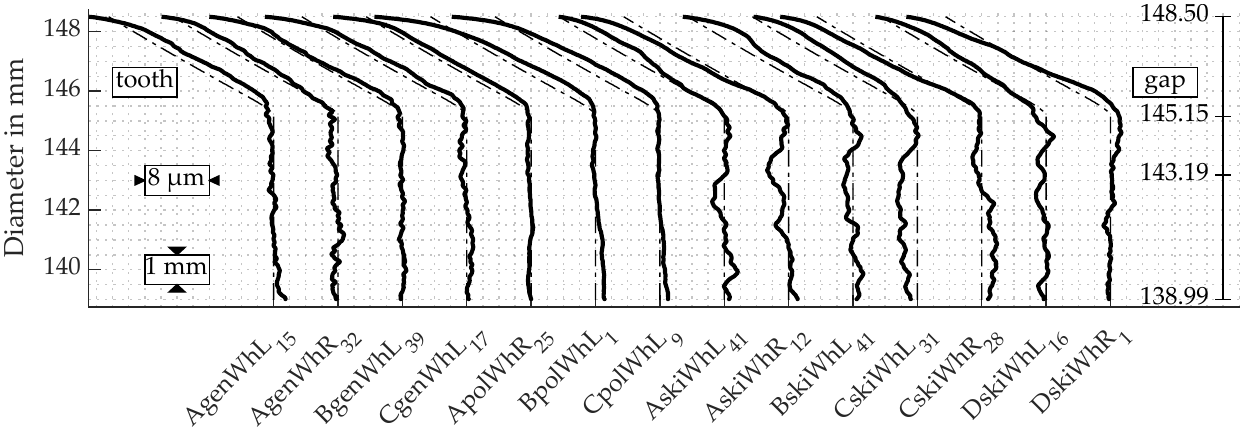
Figure 15. Profile lines of chosen teeth of all tested pinions.